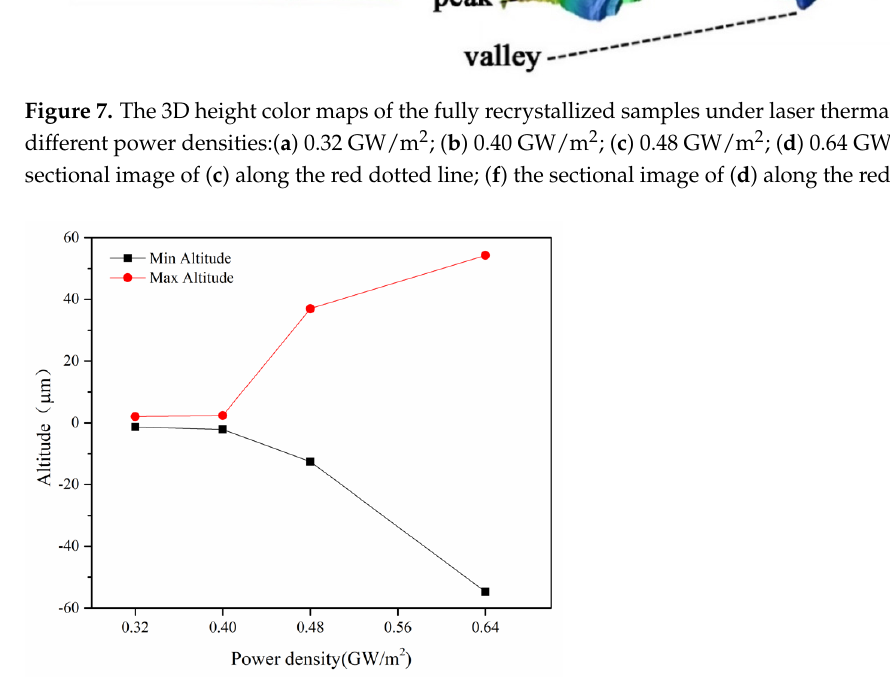
Figure 8. The variation of the maximum height value and the minimum height value of the fully recrystallized samples with the power density.